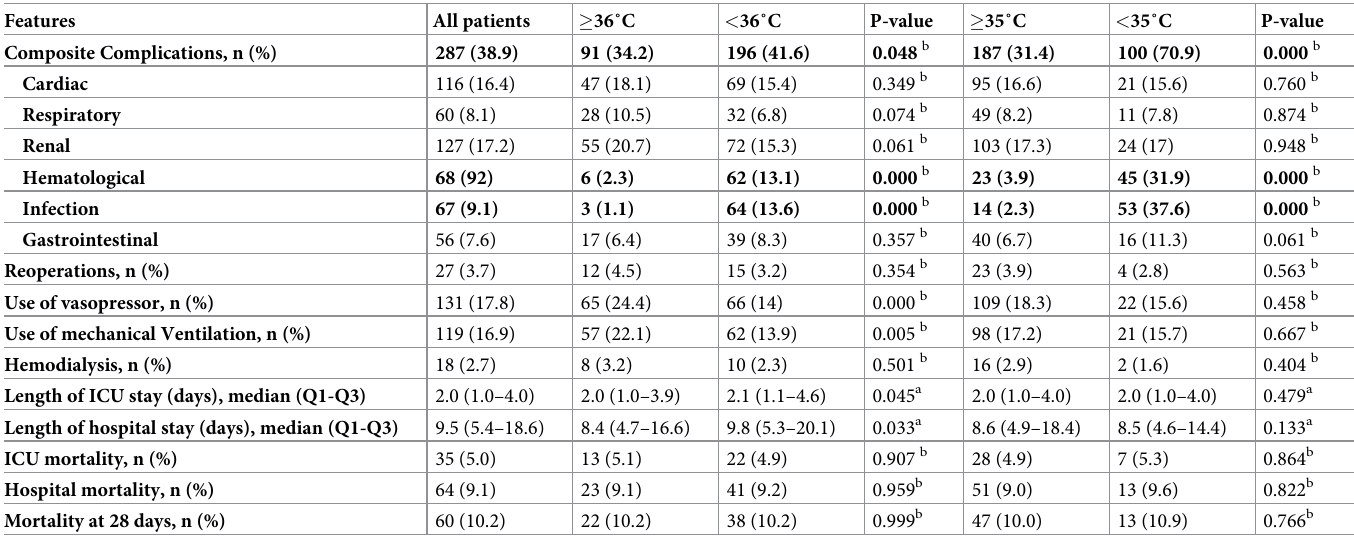
Table 2. Clinical outcomes in patients with and patients without (severe) postoperative hypothermia.